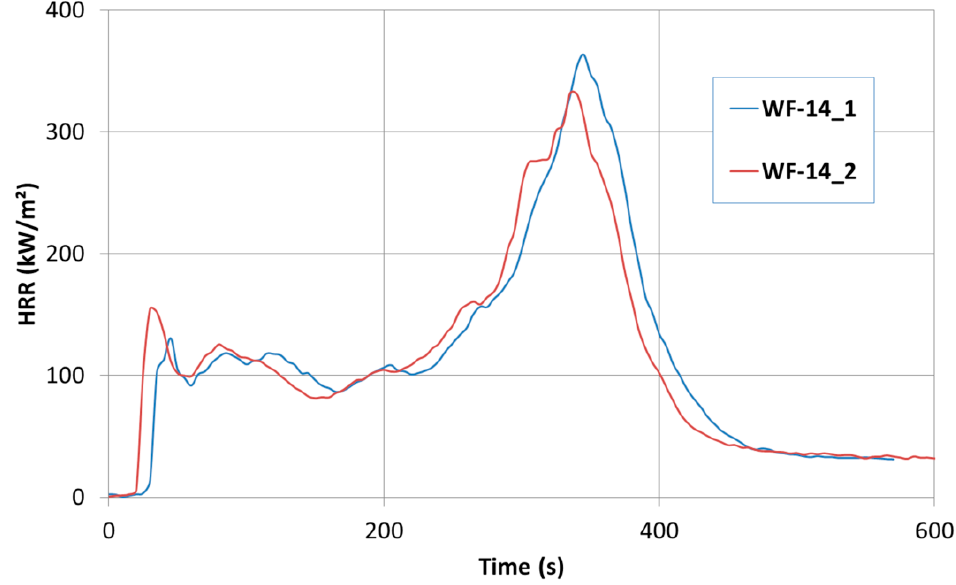
Figure 8. Heat Release Rate (HRR) curves vs. time in the cone calorimeter ISO 5660-1 for coating WF-14 (two tests).